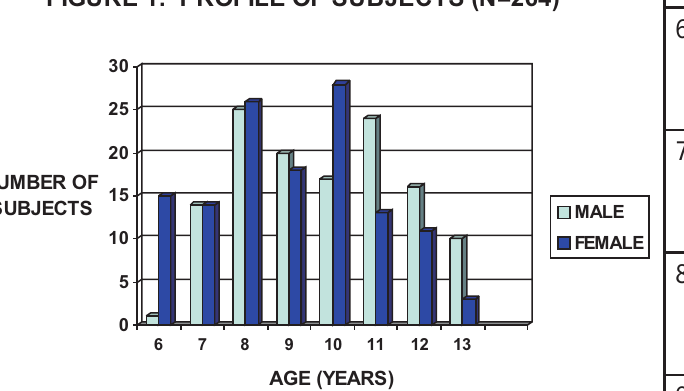
FIGURE 1: PROFILE OF SUBJECTS (N=264)